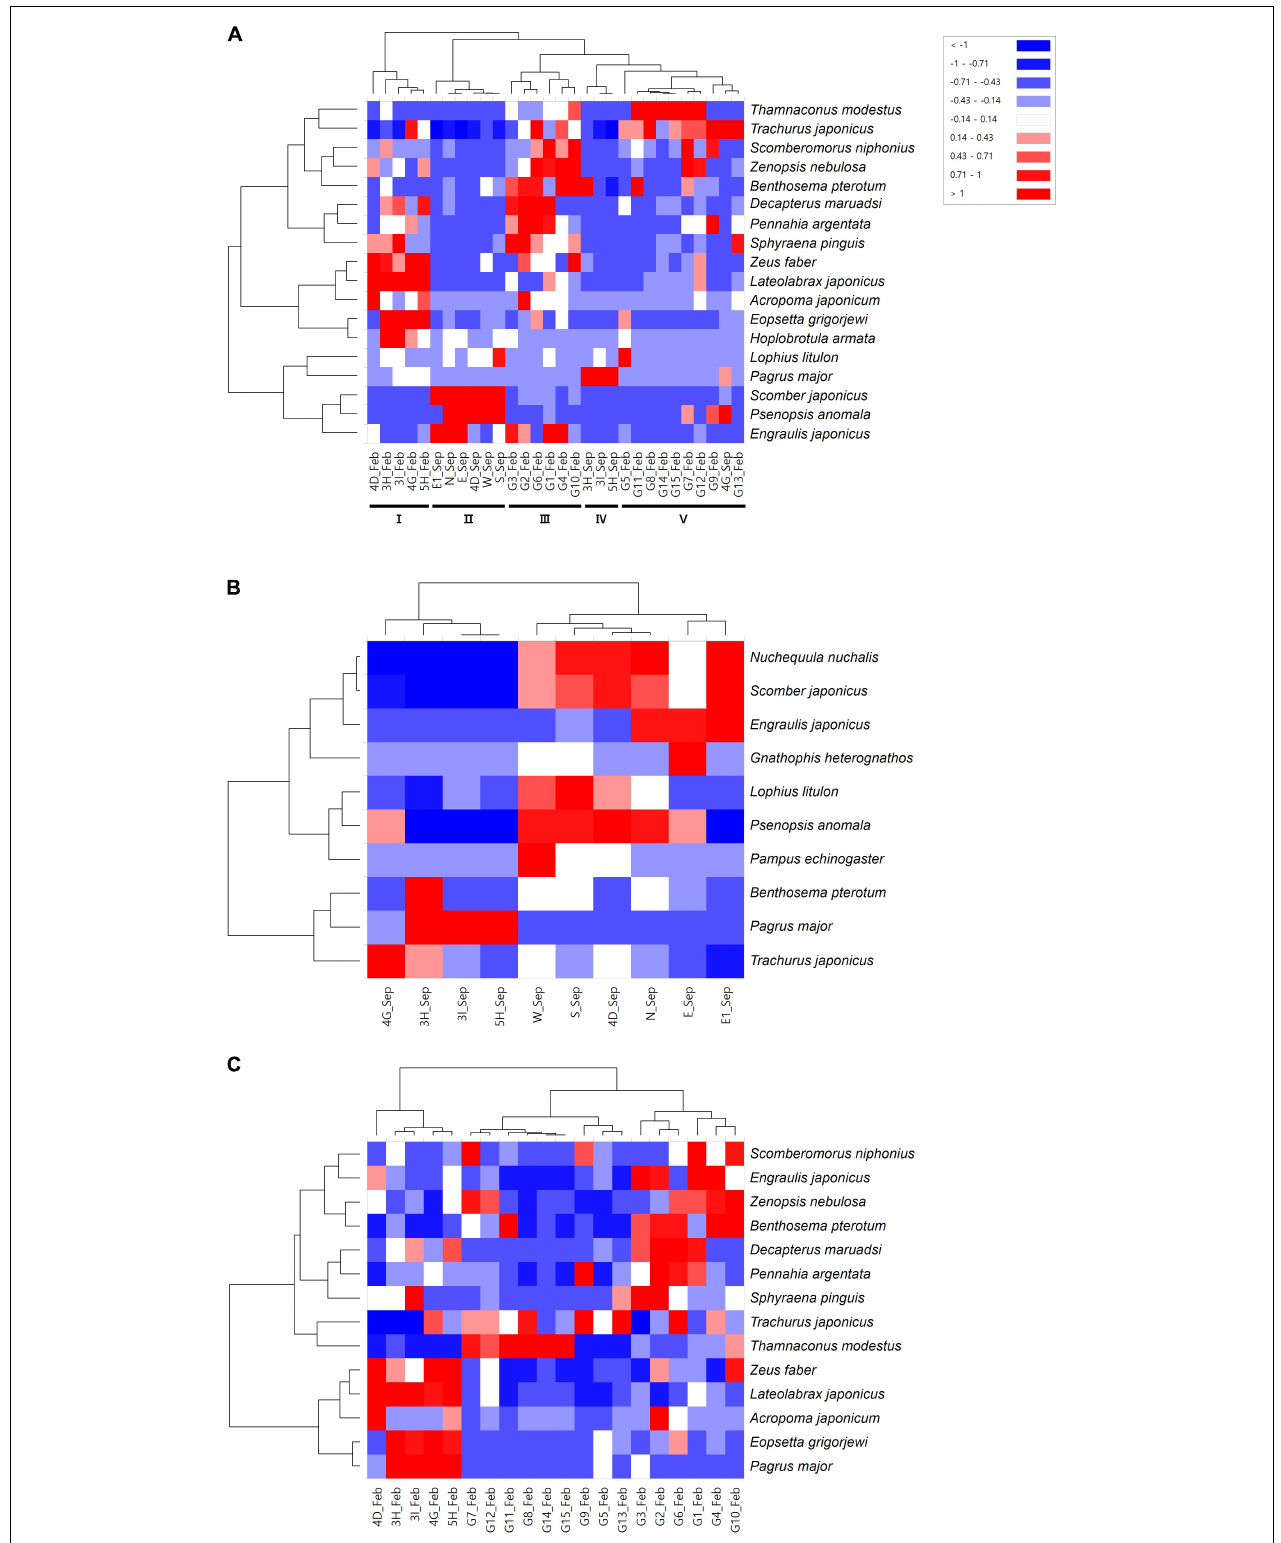
FIGURE 5 | Heatmap analysis for fish species identified at each sample collection site [ (A) Merge; (B) September; and (C) February; clades are shown in Roman numerals].